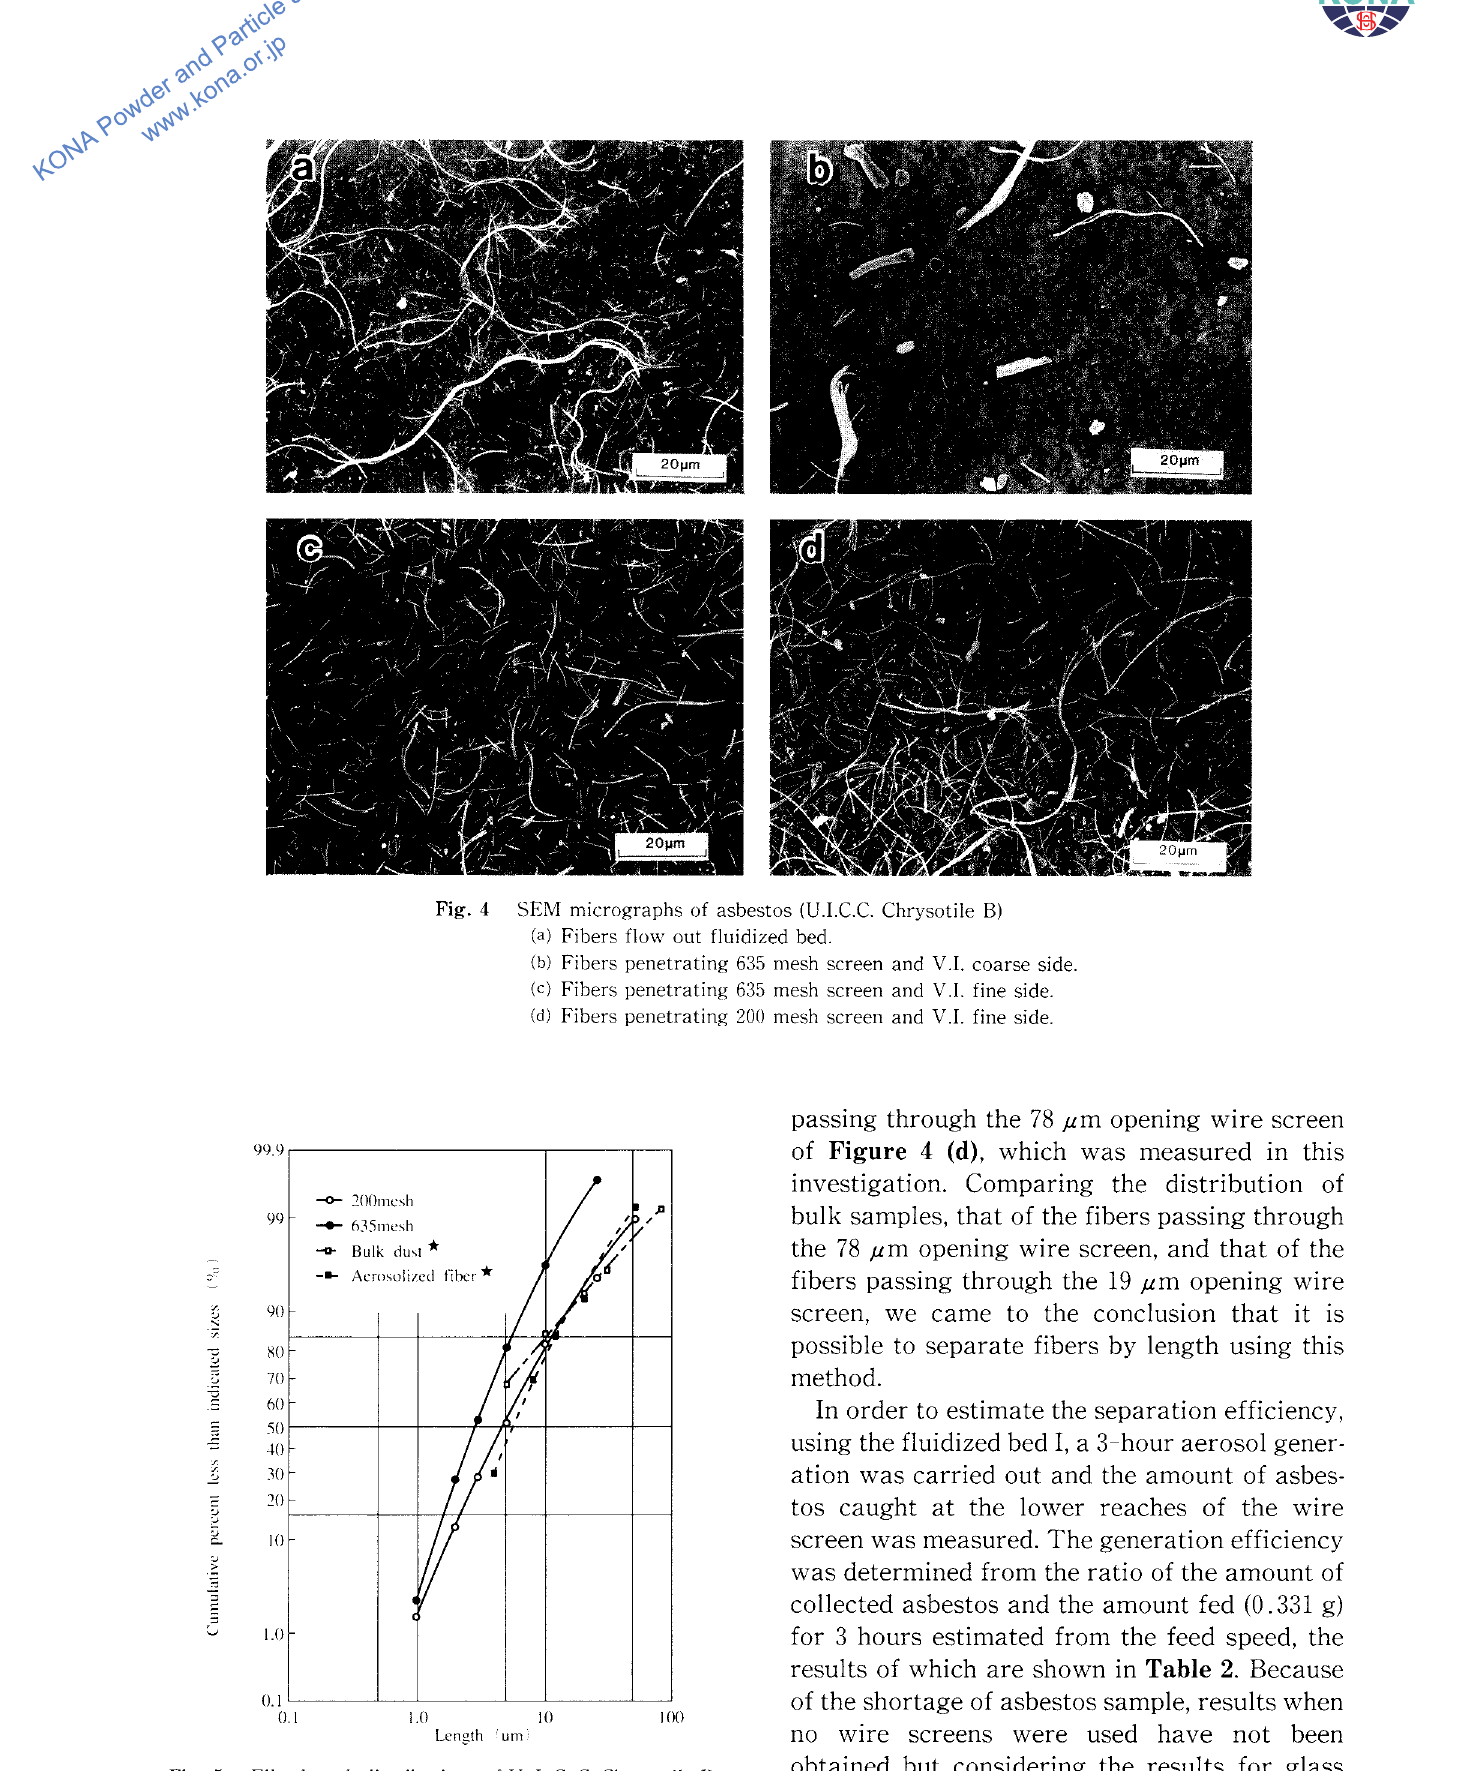
Fig. 5 Filer length distributions of U. I. C. C. Chrysotile B. * : length distribution measured by Timbre II (5)